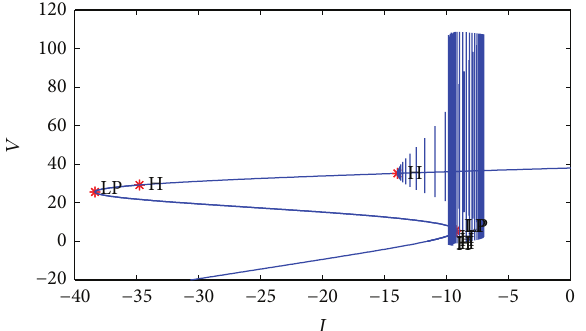
Figure 9: The limit cycle emerging from uH at 𝐼 = −13.971904 .